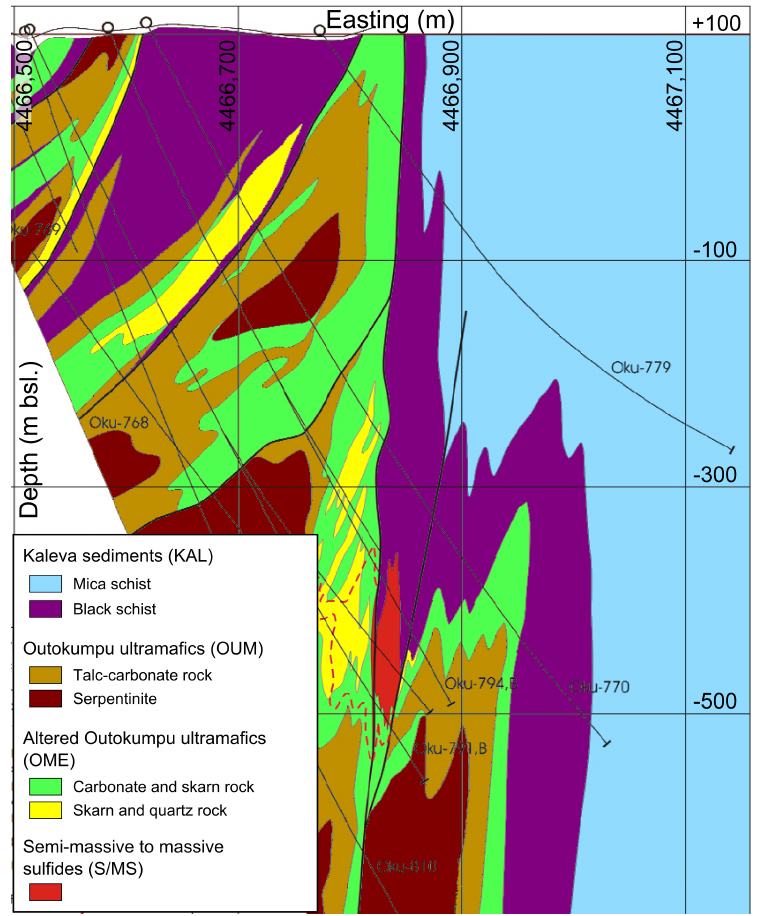
Figure 1. Vertical cross-section from west to east showing the predominant geological units of the Kylylahti mine area (modified after [40]). The red dashed line is the 1000 ppm Cu isopleth that constrains the extent of the ore-grade Co-Cu sulfide disseminations flanking the massive-semimassive